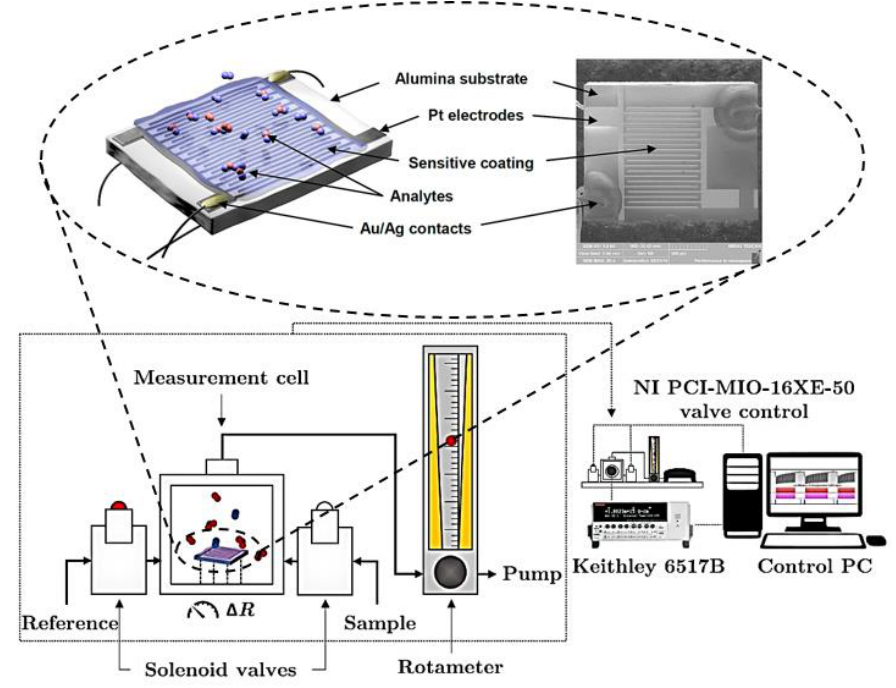
Figure 1. Schematics for measurement of the sensor response to nitrogen dioxide using an alumina chemiresistor substrate equipped with Pt electrodes in an interdigital